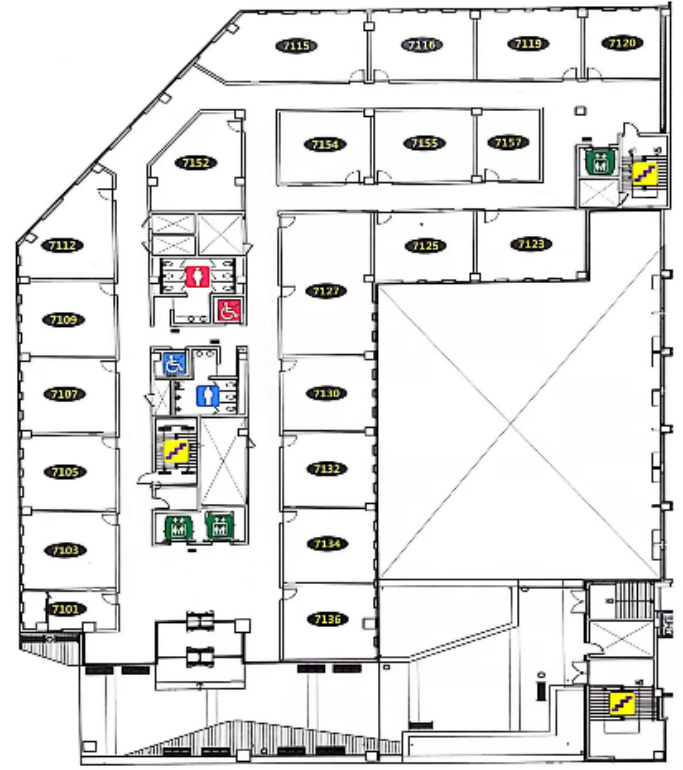
Figure 8. Floor plan of the experimental test scene.